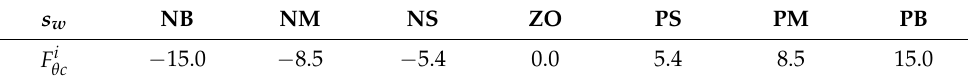
Table 1. The fuzzy rules for the FMBC.